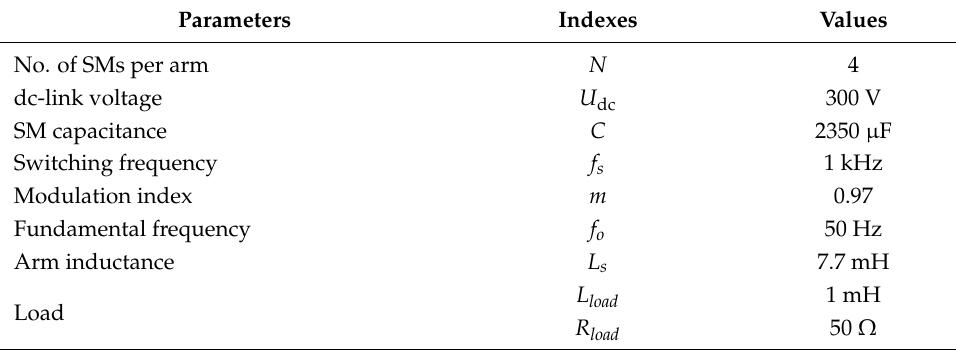
Table 5. Experimental